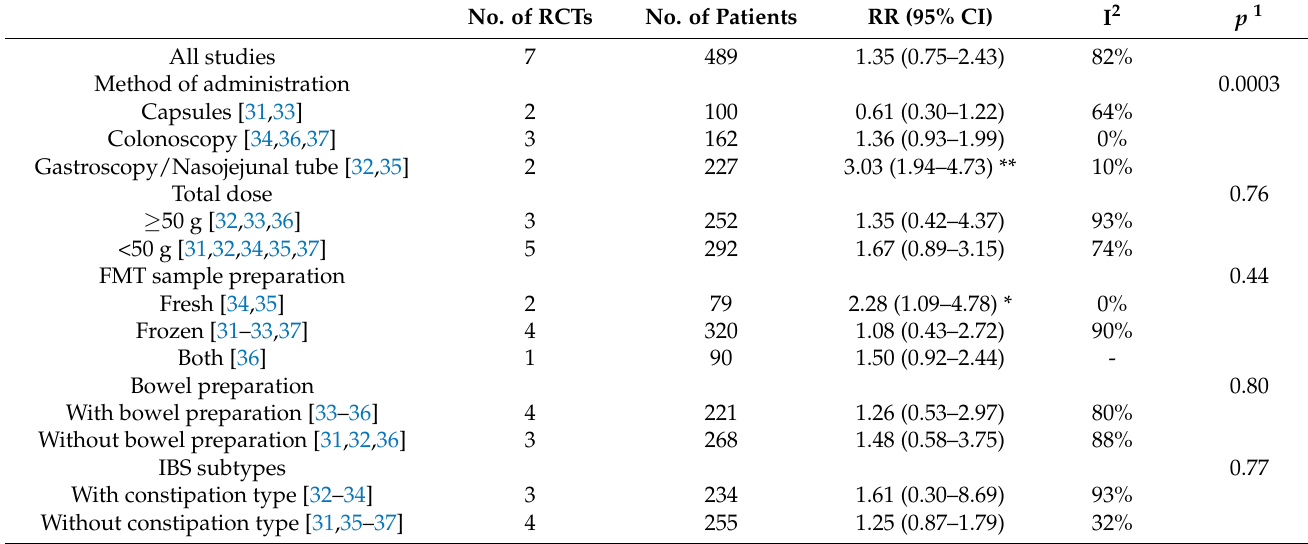
Table 3. GRADE summary of evidence on the efficacy of FMT in IBS by administration method. Table 4. Subgroup analyses of comparisons of FMT vs placebo in